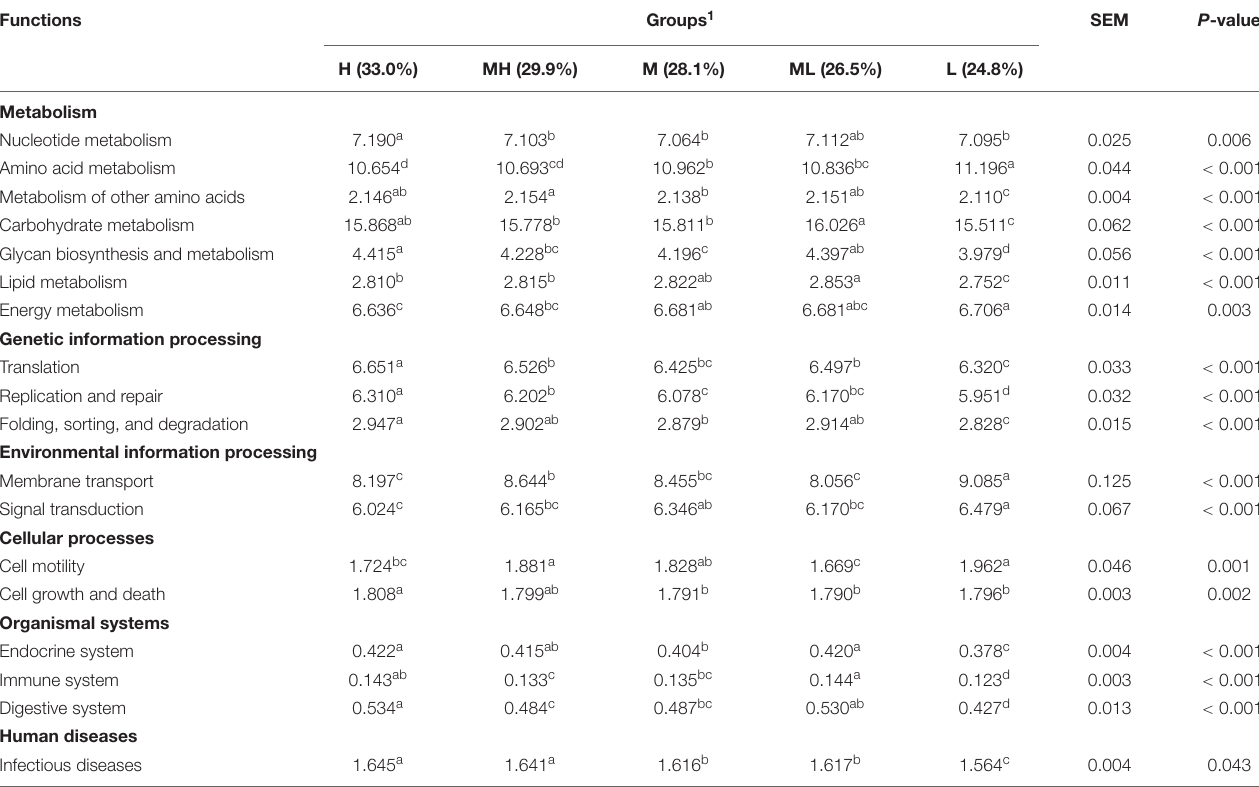
TABLE 8 | Effects of dietary peNDF 1 . 18 level on the prediction of rumen bacterial function (%). Functions Groups 1